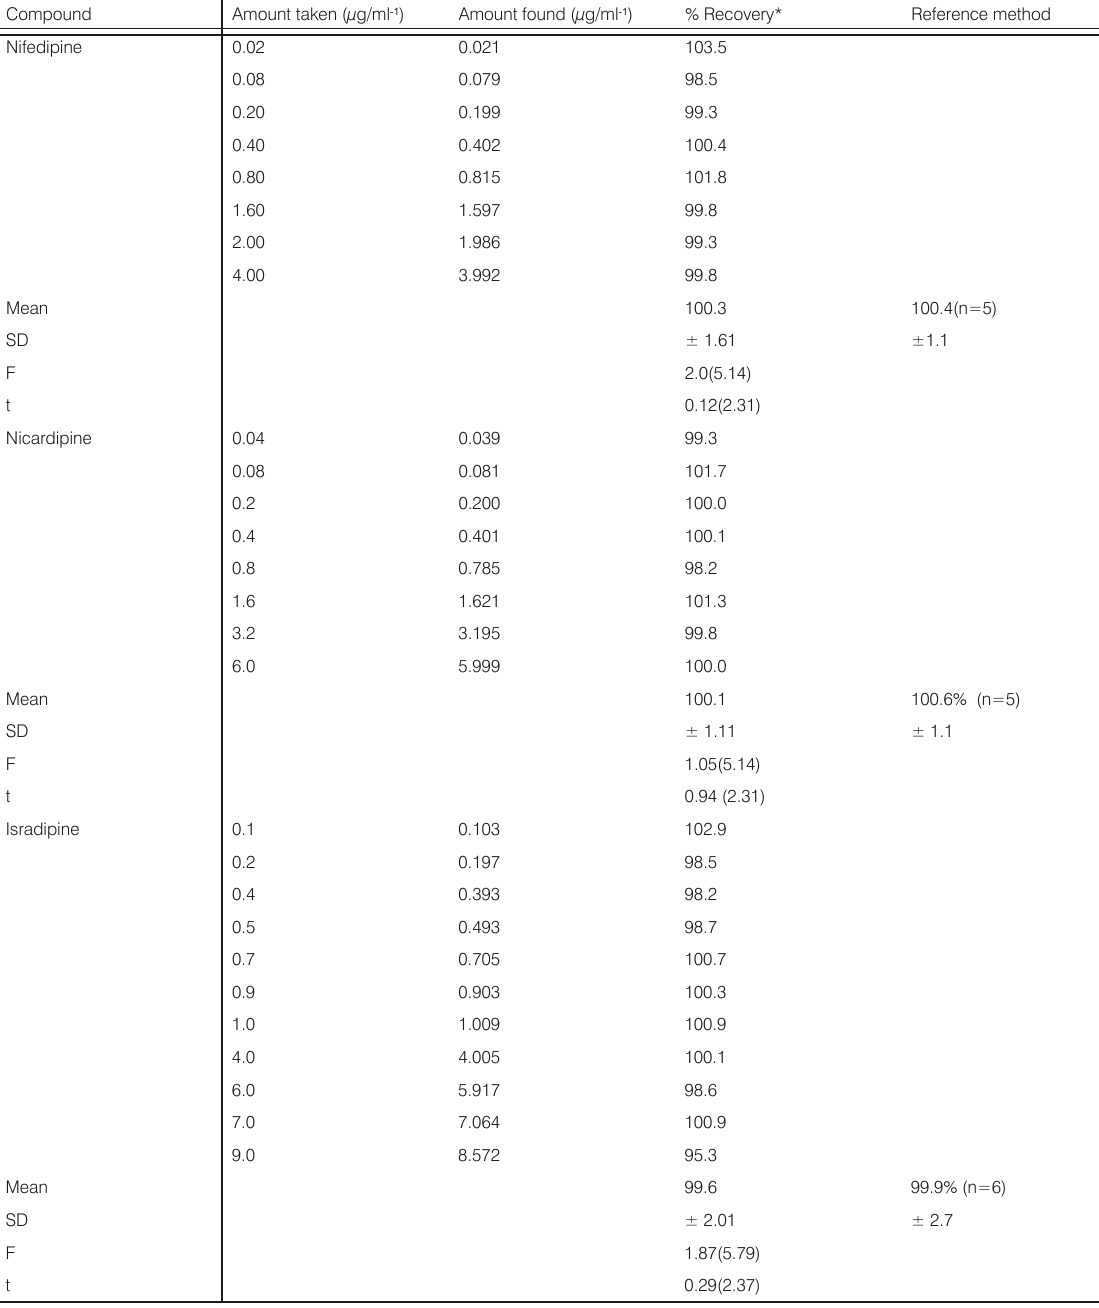
Table 2. Spectrofluorimetric determination of the studied compounds in pure